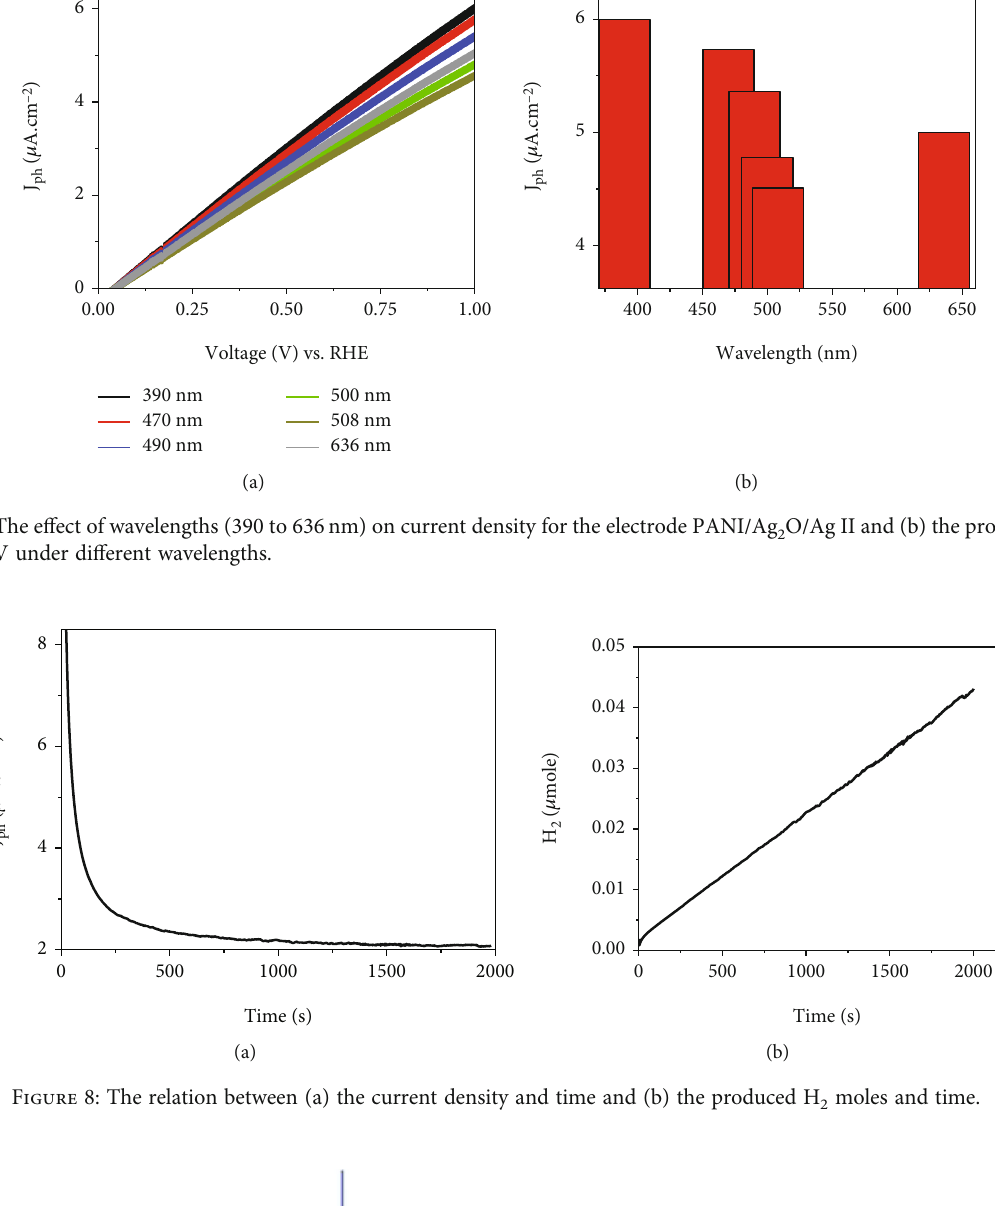
moles and time. 2